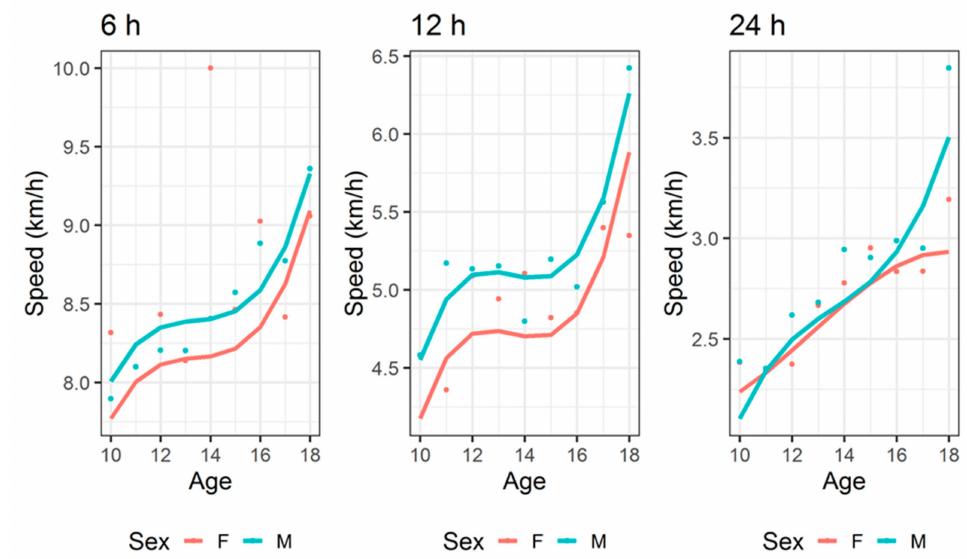
Figure 5. Running speed across age groups for time-limited ultra-endurance events for 6, 12 and 24 h. Fitted values = line, points = observed mean